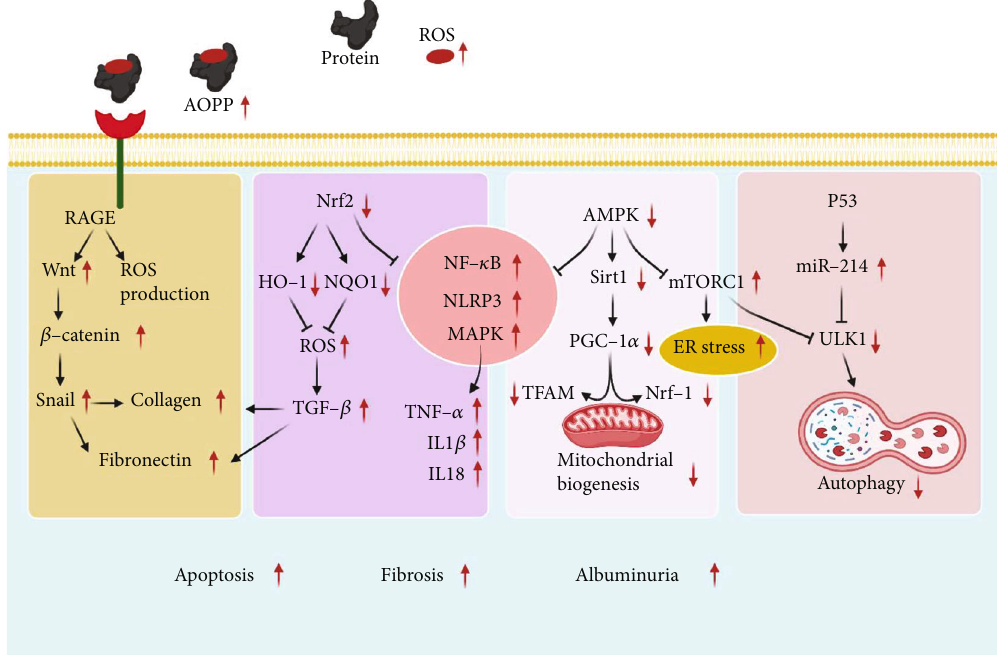
Figure 2: Impaired signaling pathway in diabetic nephropathy. Overproduction of ROS and subsequent release of AOPP activate RAGE, which exacerbates ROS production and accelerates renal fi brosis by upregulating Wnt/ β -catenin/Snail pathway and TGF- β /Smad pathway. Patients with diabetic nephropathy simultaneously su ff er from an insu ffi cient antioxidant defense due to impaired Nrf/HO-1/ NQO1 pathway. Downregulation of AMPK/Sirt1/PGC-1 α in diabetic nephropathy undermines mitochondrial biogenesis. Furthermore, the inhibitory e ff ect of Nrf2 and AMPK on in fl ammatory signaling molecules such as NF- κ B, NLRP3, and MAPK is weakened in diabetic nephropathy. Moreover, overactivation of mTORC1 and P53/miR-214 inhibits ULK-1 and autophagy in diabetic nephropathy. The outcome of these molecular alterations is apoptosis, albuminuria, and fi